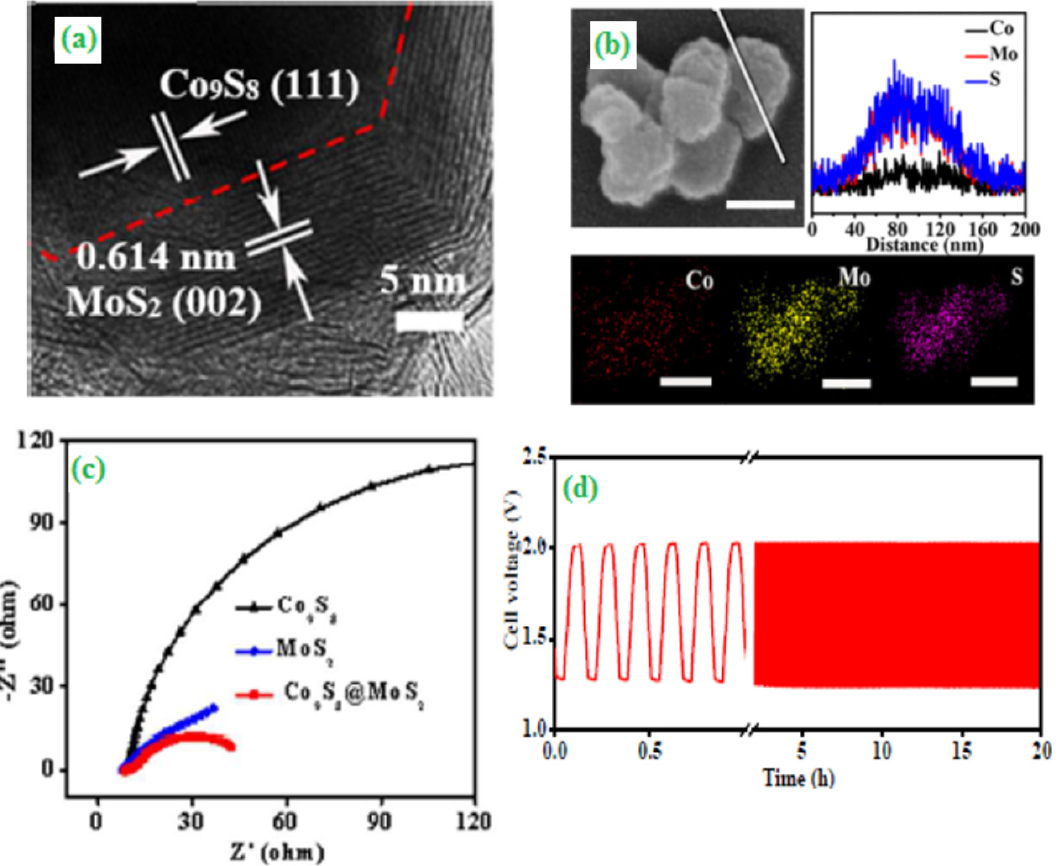
Figure 7. ( a ) HR-TEM image of the Co 9 S 8 @MoS 2 , ( b ) FE-SEM image (scale bar: 100 nm), correspond- ing cross-sectional compositional line-scan profiles and elemental mapping of the Co 9 S 8 @MoS 2 , ( c ) EIS plots recorded at − 0.143 V and ( d ) Galvanostatic charge-discharge cycling at a current density of 10 mA cm − 2 . Copyright 2018 by American Chemical Society [63].